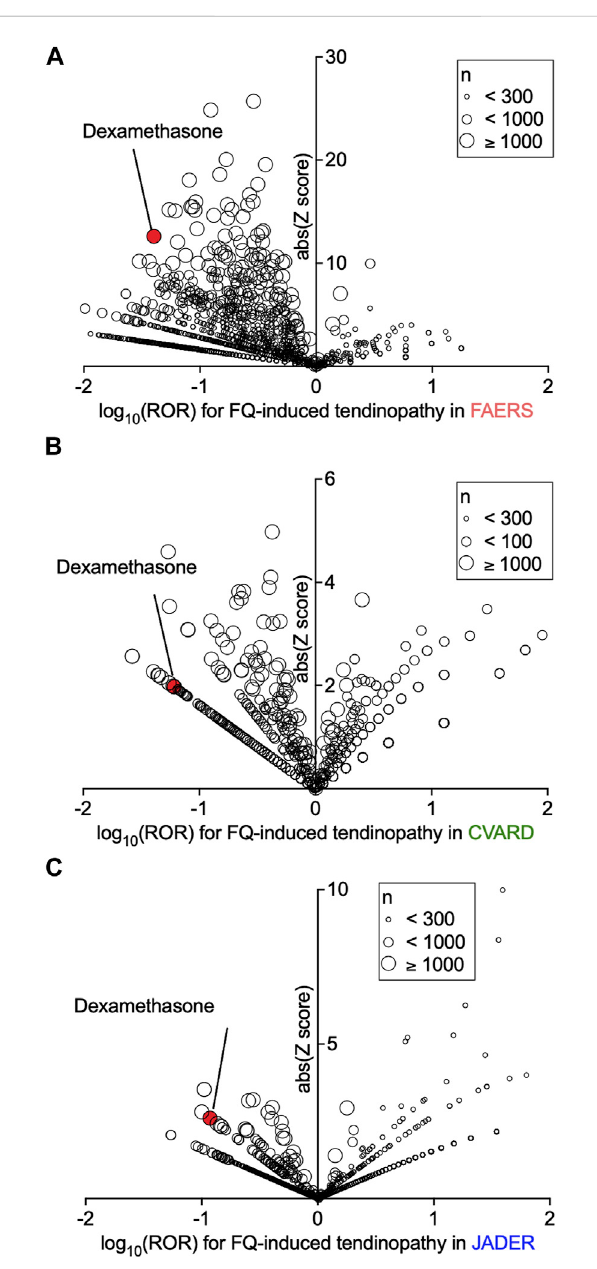
FIGURE 2 Confounding effects of concomitant drugs on fl uoroquinolone- induced tendinopathy in patients registered in the FDA Adverse Event Reporting System (FAERS), Canada Vigilance Adverse Reaction Online Database (CVARD), and Japanese Adverse Drug Event Report (JADER). The confounding effects of all drug combinations on the reporting odds ratio (ROR) for tendinopathy were calculated. Volcano plots visualizing the ROR (on a log scale) and its statistical signi fi cance (absolute Z score) from FAERS (A) , CVARD (B) , and JADER (C) are shown. The overall values are presented in Supplementary Data